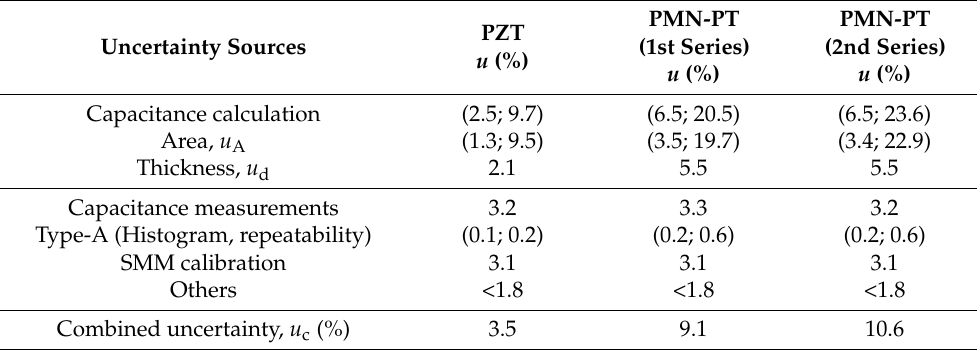
Table 2. Uncertainty sources included in the current metrological workflow presented in this work and the combined uncertainty u c corresponding to the dielectric constant values measured on PZT and PMN-PT samples.